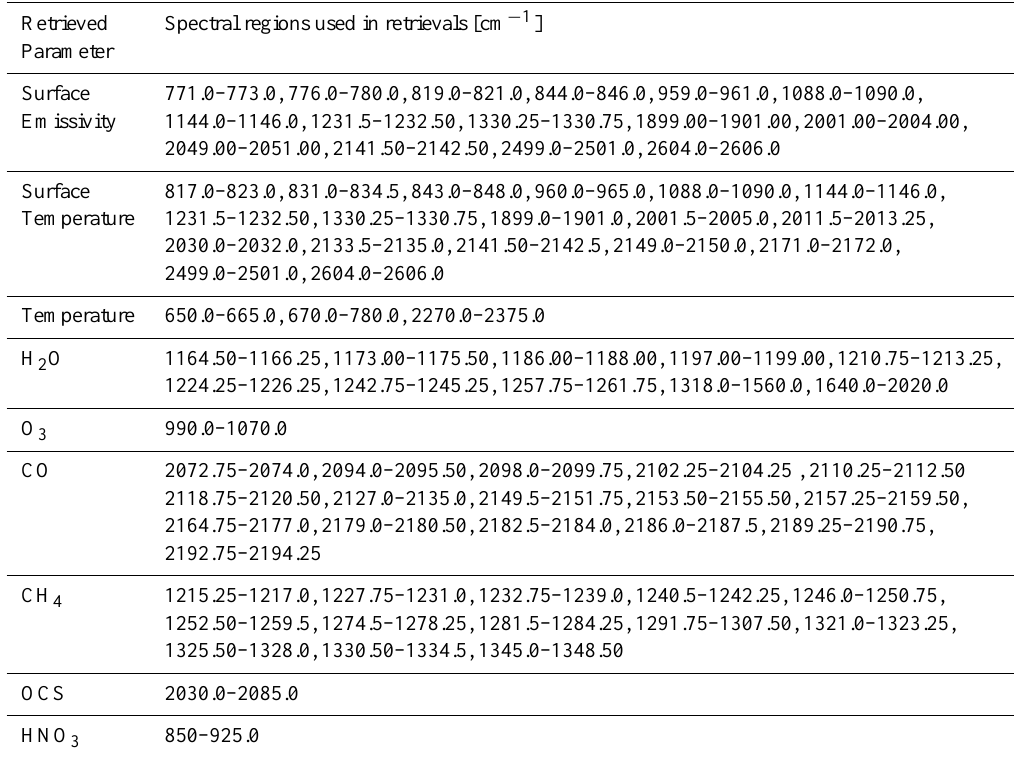
Table 1. List of spectral regions used in